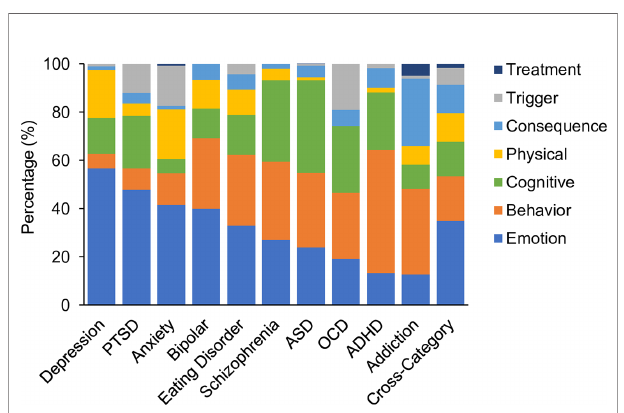
FIGURE 3 | Comparative proportion by symptom theme. Emotion; (mid blue), behavior (orange), cognitive (green), physical (yellow), consequence(s) (pale blue) and trigger(s) (gray), or the treatment(s) of a symptom (dark blue). Values are averages across assessment tools for each disorder and for cross-disorder